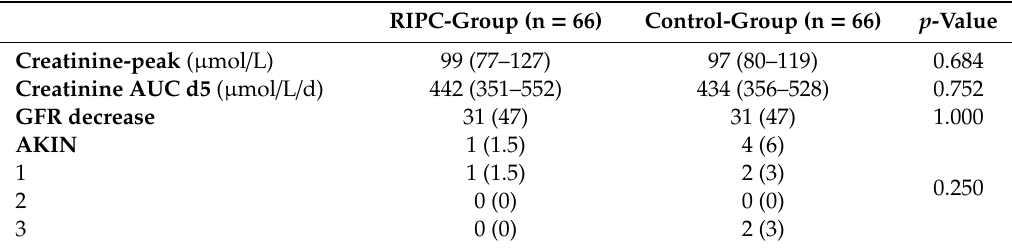
Table 3. Kidney-specific parameters for RIPC- and matched control-group.